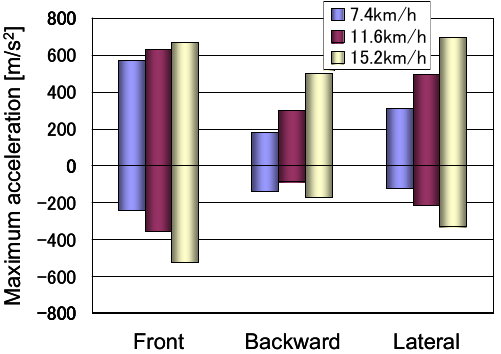
Fig. 8 Comparison of positive or negative maximum acceleration for impacts at 7.4, 11.6, and 15.2 [km/h] for each impact direction.